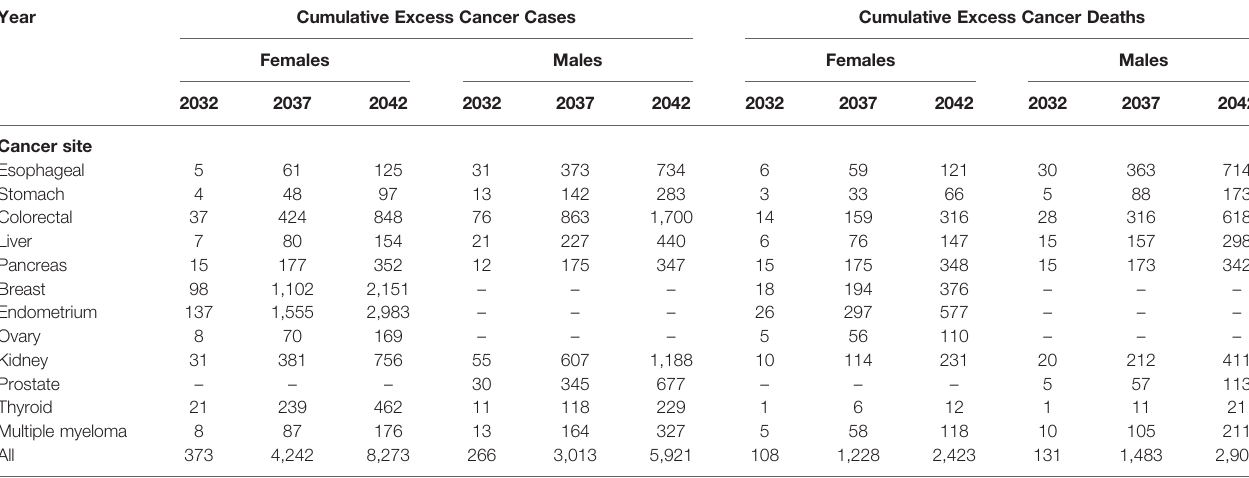
TABLE 3 | Projected cumulative excess cancer incidence and mortality due to body weight change during the COVID-19 pandemic in 2020/21 by sex, assuming 42.3% of population gained weight and 15.6% lost